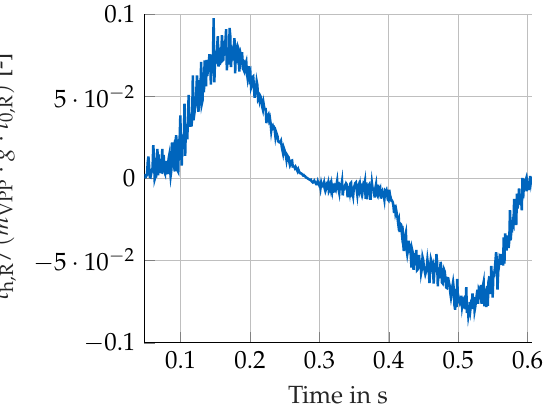
Figure 10. Total hip torque normalized over body weight and leg length during the stance phase of the right